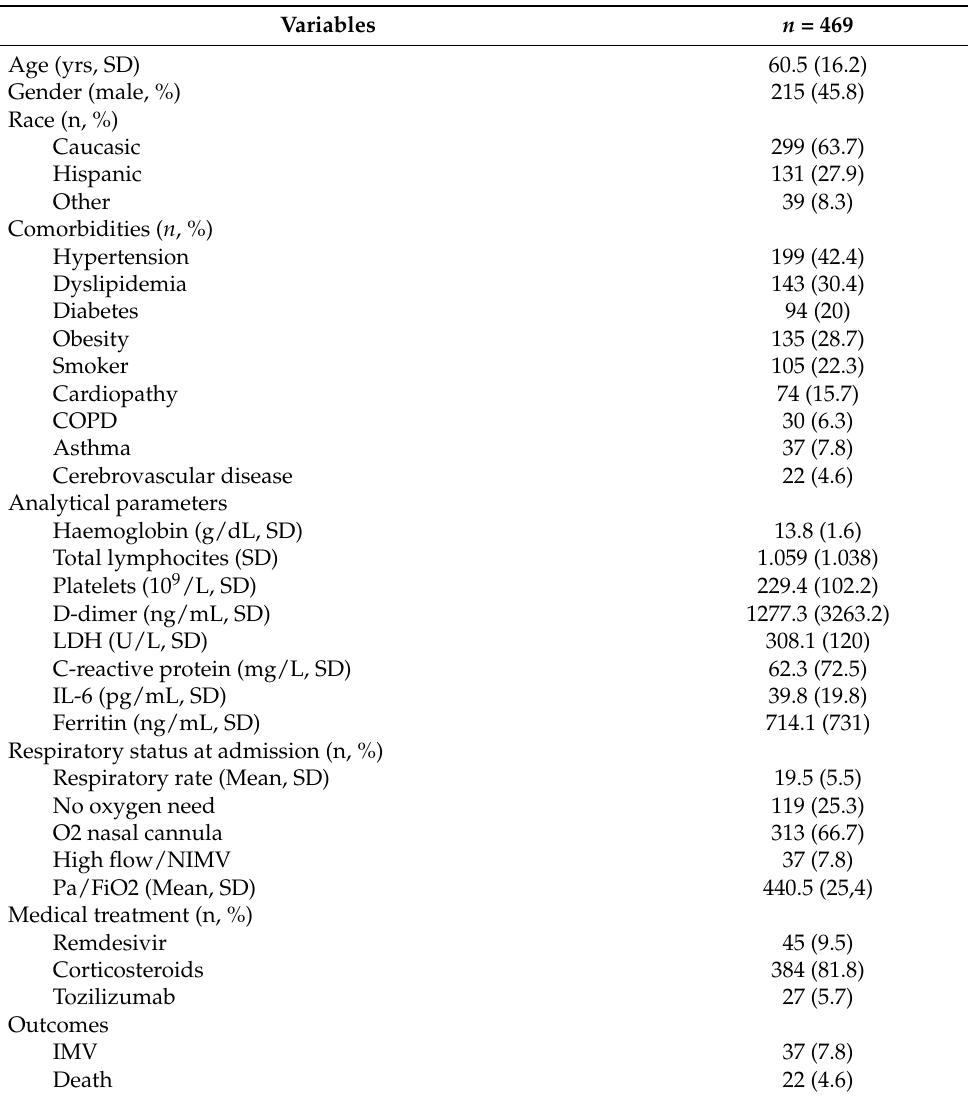
Table 1. Baseline demographic and clinical characteristics of